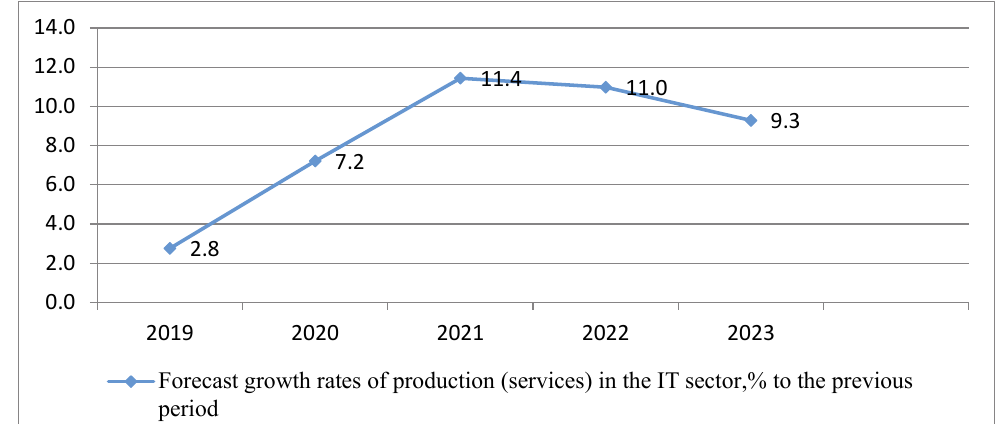
Fig. 6. Forecast extrapolation trend of production (services) growth in the IT sector of Ukraine Source: calculated by the